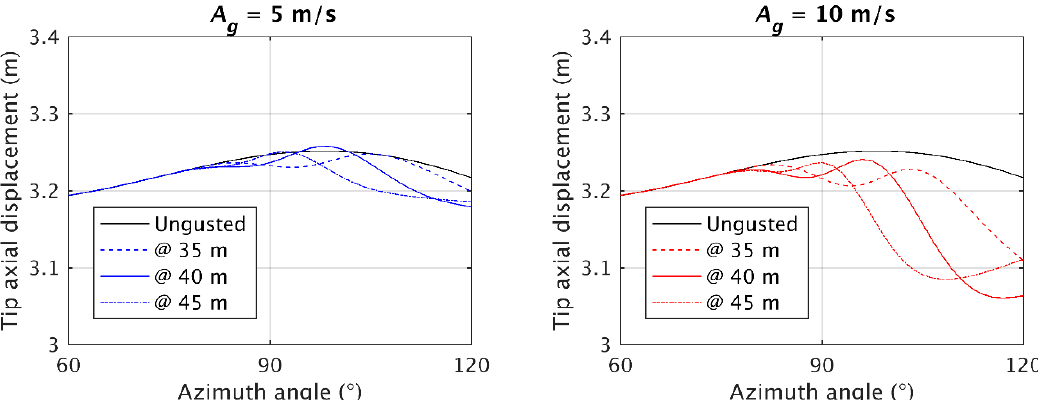
Figure 7. Effect of the radial position of the gust center on the tip axial displacement: ( left ) gust with 5 m/s amplitude and ( right ) 10 m/s amplitude.